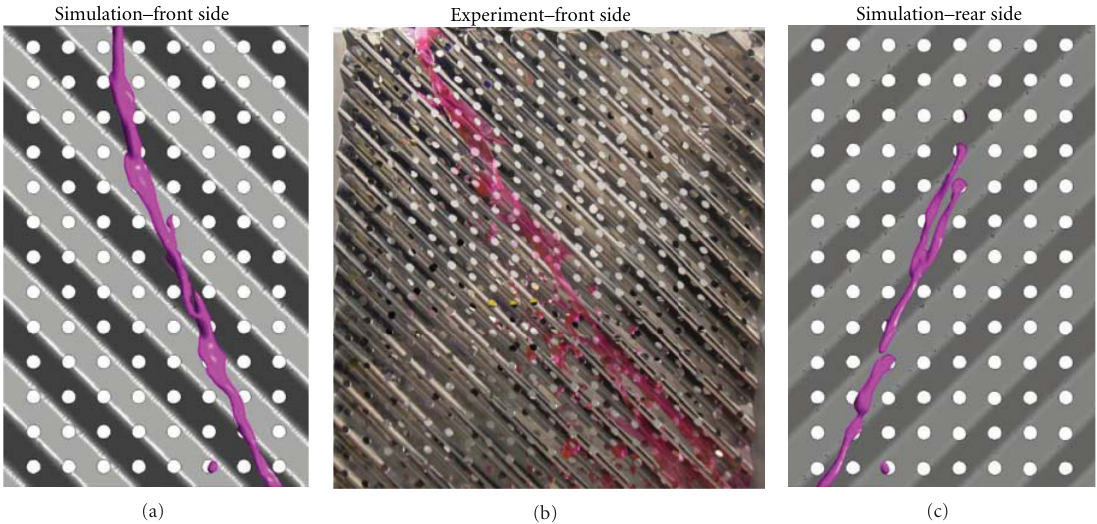
Figure 13: Comparison between simulation and experiment for flow of water on corrugated sheet of packing with perforations. Flow rate: 386mL/min.